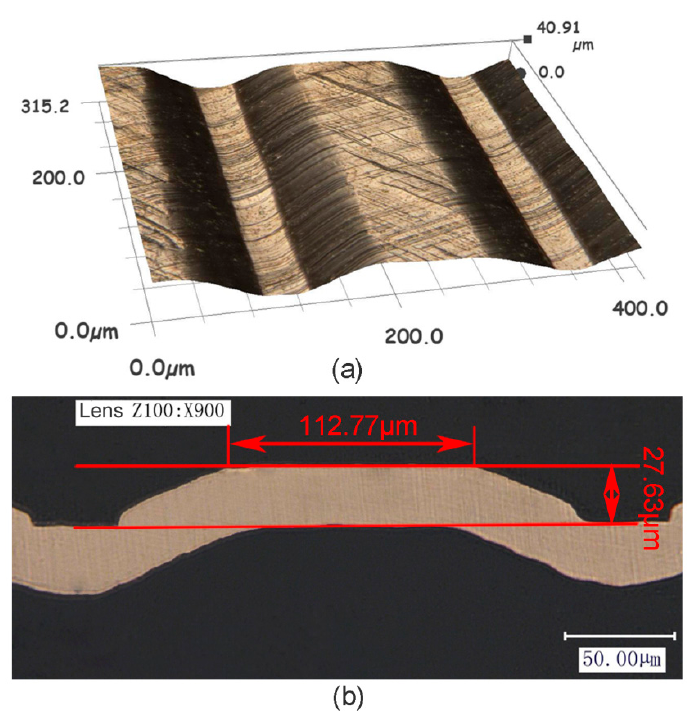
Figure 8. ( a ) 3-D morphology of one formed microchannel and ( b ) cross-section morphology of Figure 8. ( a ) 3 ‐ D morphology of one formed microchannel and ( b ) cross ‐ section morphology of one one microchannel. microchannel.